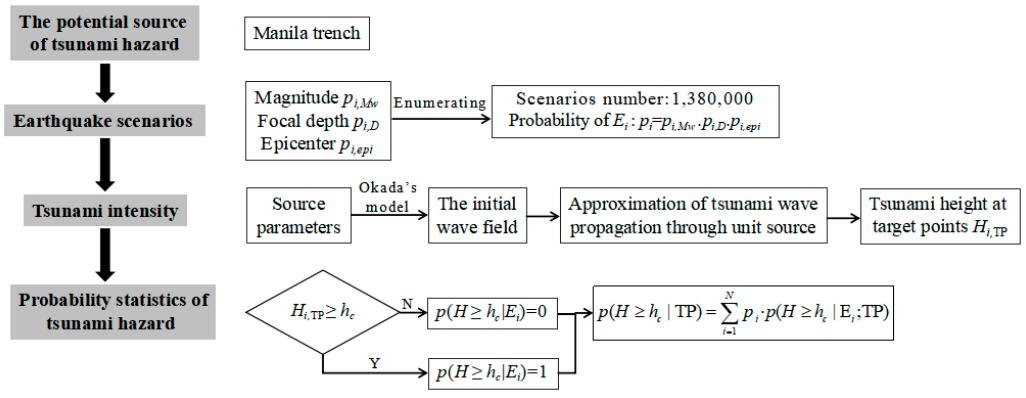
Figure 1. Process of probabilistic tsunami hazard assessment.